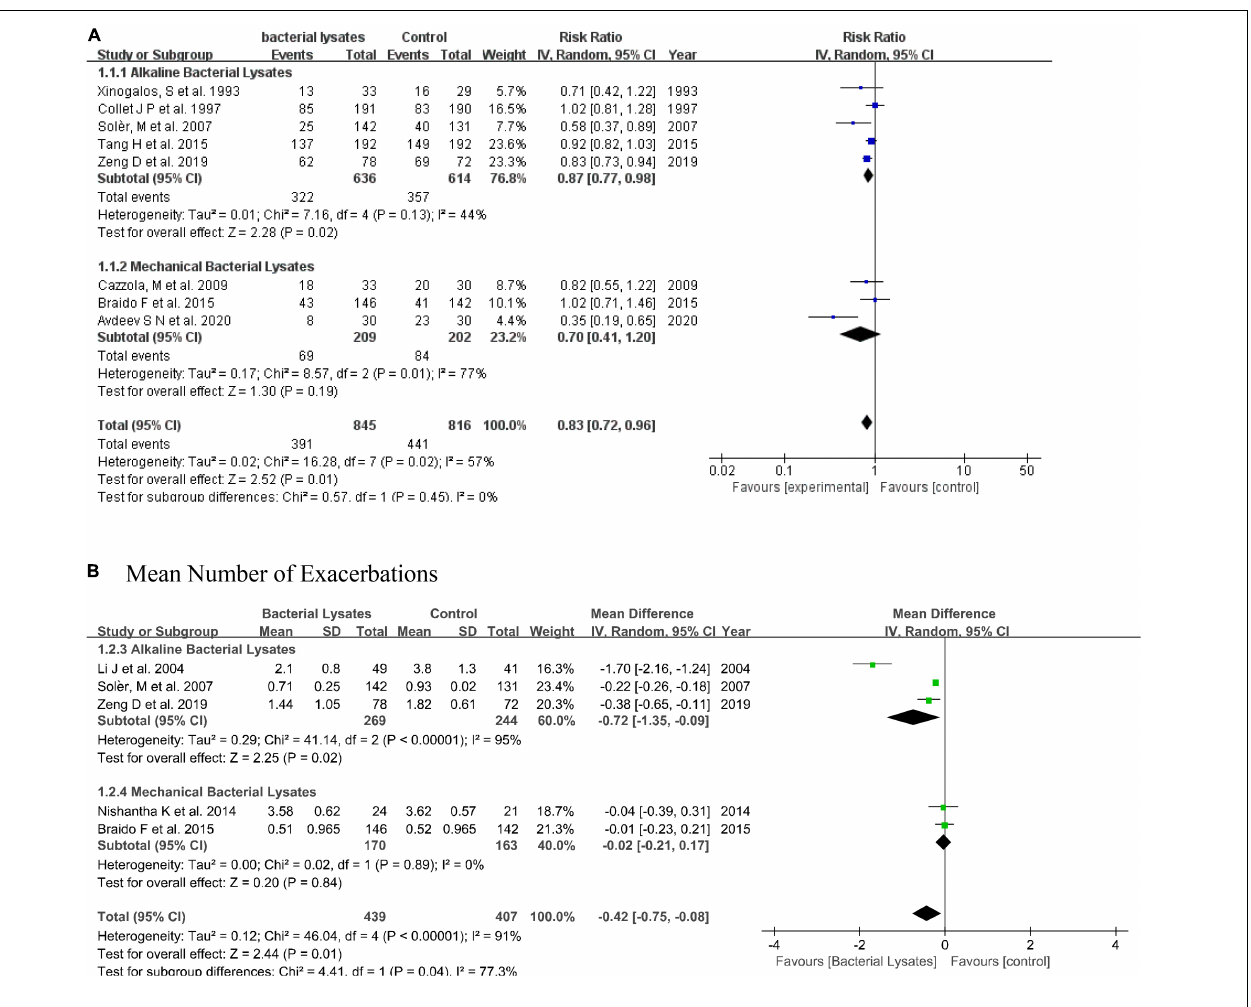
FIGURE 3 | Forest plot of the efficacy of bacterial lysates on exacerbations. (A) Forest plot of rate of exacerbation. (B) Forest plot of mean number of